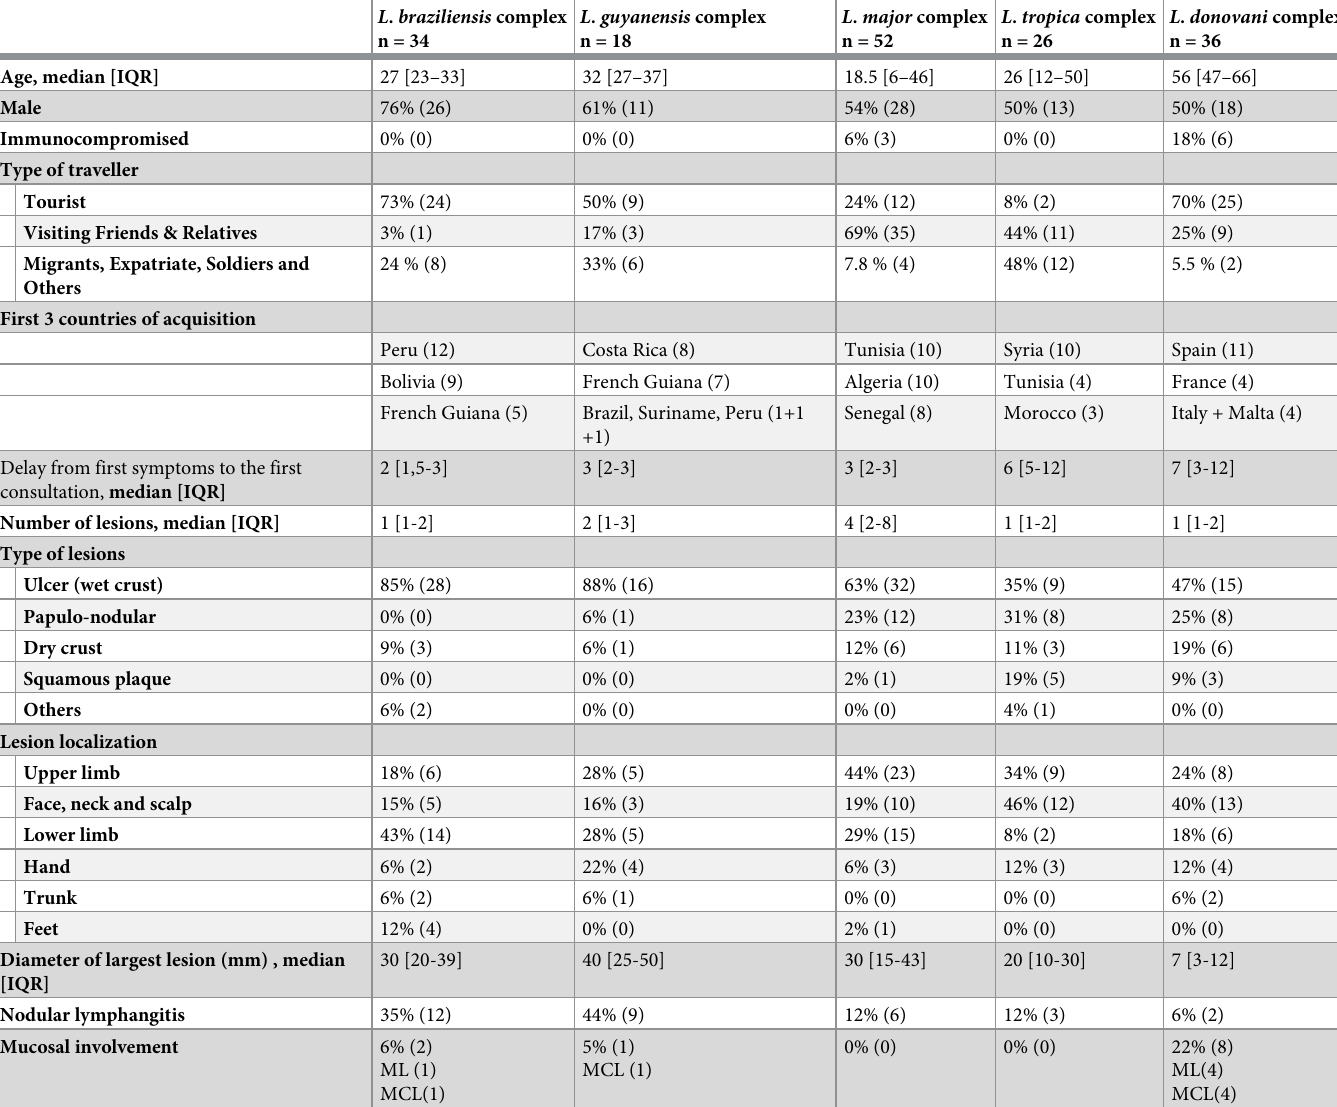
Table 2. Comparative features of 166 cases of cutaneous, mucocutaneous and mucosal leishmaniasis by main infecting complex